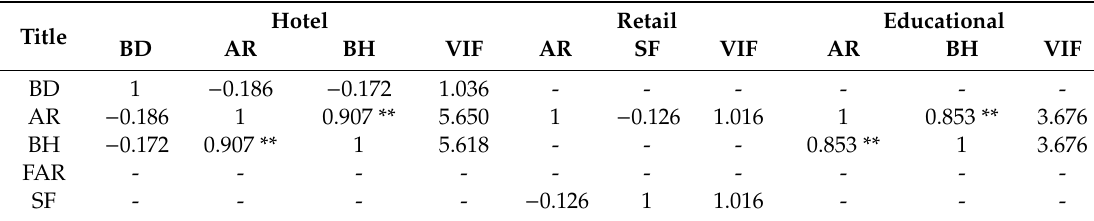
Pearson correlations between urban morphological parameters of hotel, retail, and educational buildings.